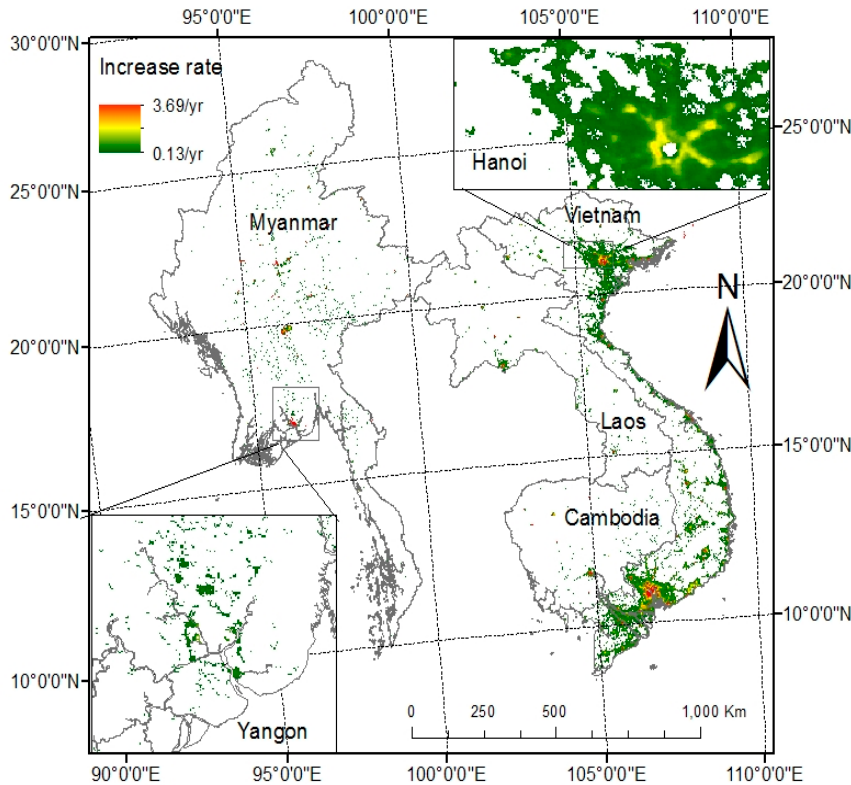
Figure 7. The increasing trends of DMSP/OLS NTL brightness in 1992 to 2010. Areas for Yangon and Hanoi were enlarged to illustrate the slow and fast change. 366